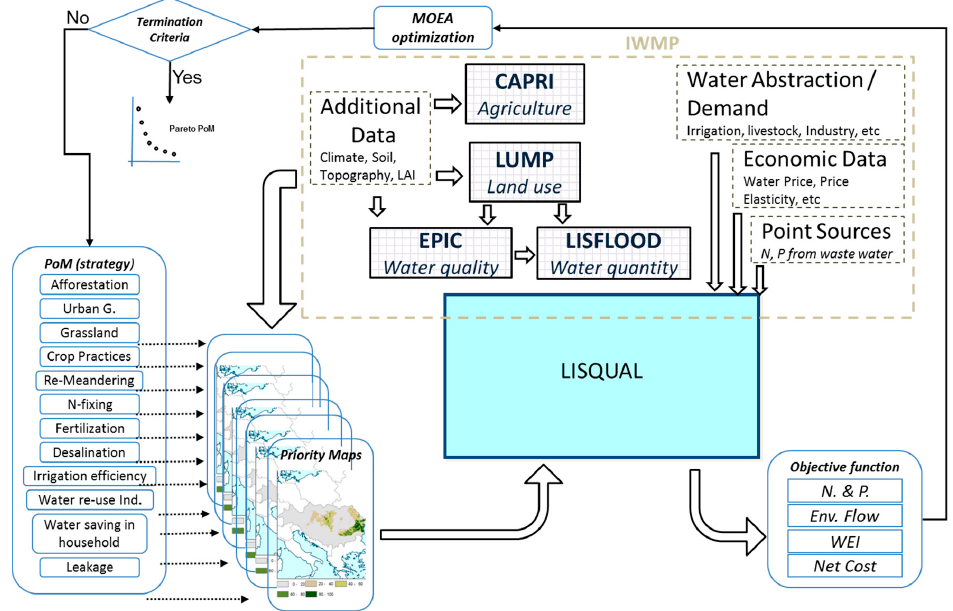
Figure 2. Flowchart of the model interlinkages and the multi ‐ criteria optimization procedure. The MOEA optimizer searches for Pareto set of PoMs with respect to the objective functions by